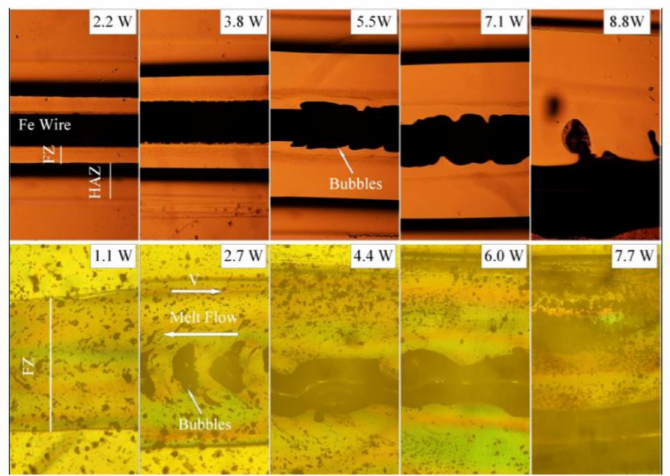
Figure 16. Optical micrographs of joints in Fe wire ( upper ) and CB groups ( lower ) with different input powers(feed speed, V = 1 mm/s and clamping pressure, C = 0.4 MPa) [208]. Reproduced with permission from Ref. [208]. Copyright (2018), Optics and Laser Technology.